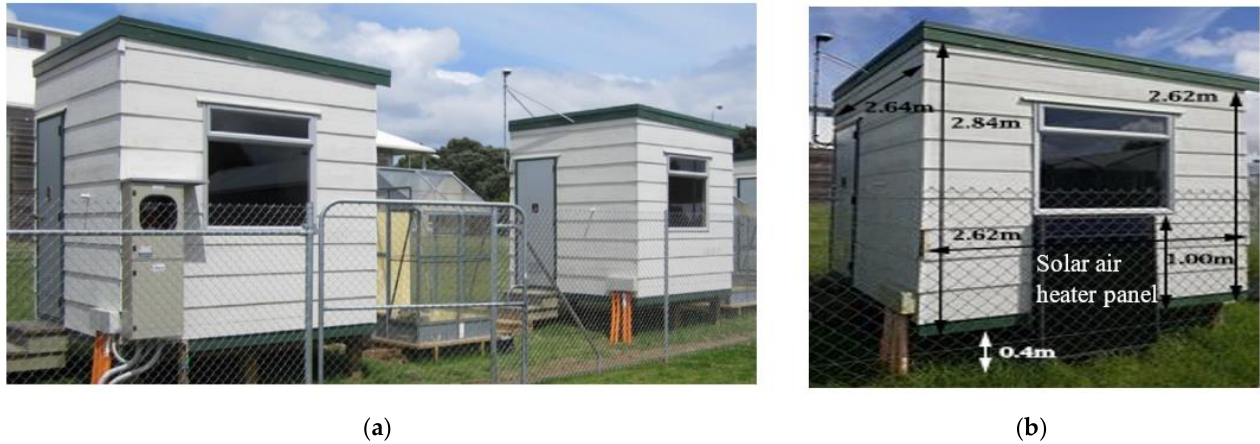
Figure 1. ( a ) The experimental test and control huts, located at the University of Auckland [22]. ( b ) The hut was supplied with a solar air heater panel [19].